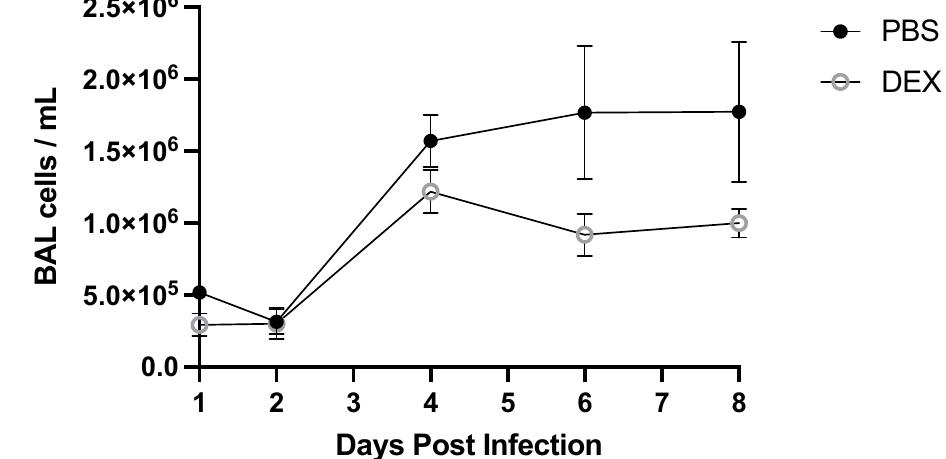
Figure 3. Total BAL cells during IBV infection. Mice were treated with PBS or 10 mg/kg DEX daily (starting on day − 1 before infection), and BAL cells were collected at indicated days pi with IBV B/Florida/04/2006. Counts were performed using a hemocytometer and Trypan blue exclusion. Data represent the mean + SEM of live BAL cells/mL (n = 3–5 mice/group/time point). No significance between PBS and DEX-treated mice on any day post-infection was detected by multiple Mann– Whitney U Tests.